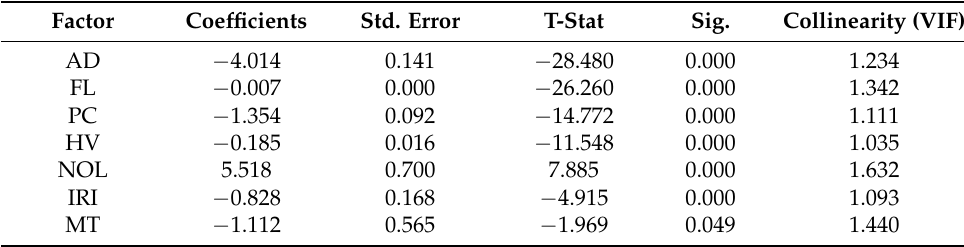
Table 5. Summary of Regression